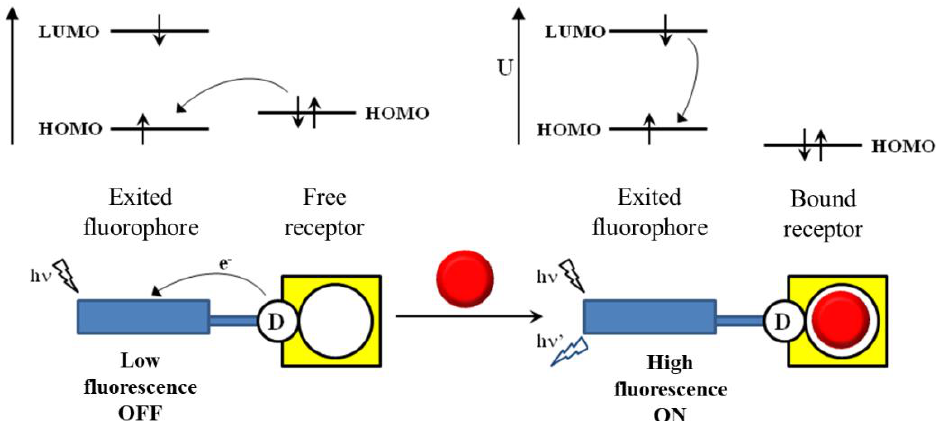
Figure 1. Scheme of the recognition of an analyte by blocking the PET process. Figure adapted from reference